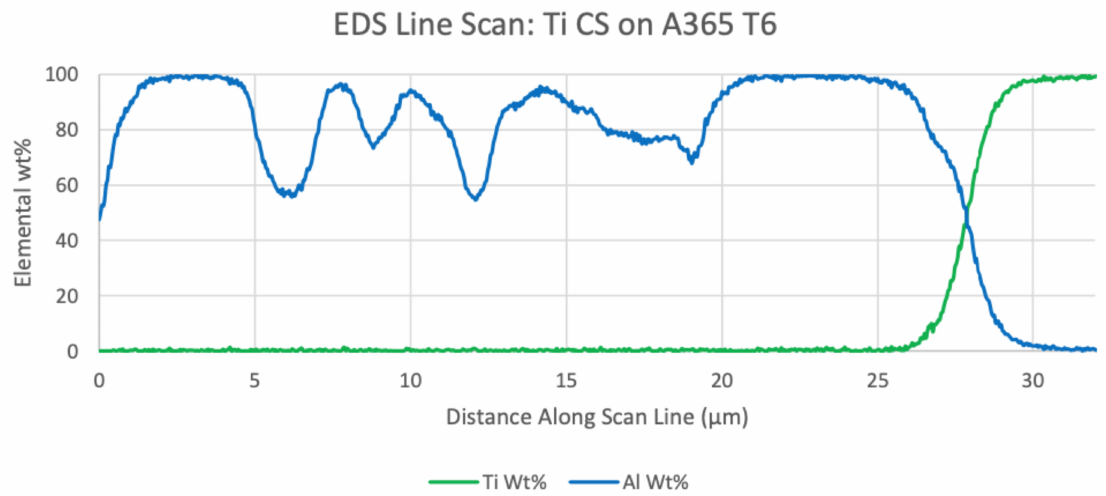
Figure 10. Presentation of the EDS line scan recorded for the Ti CGDS coated HPDC A365 substrate system in the thermally postprocessed